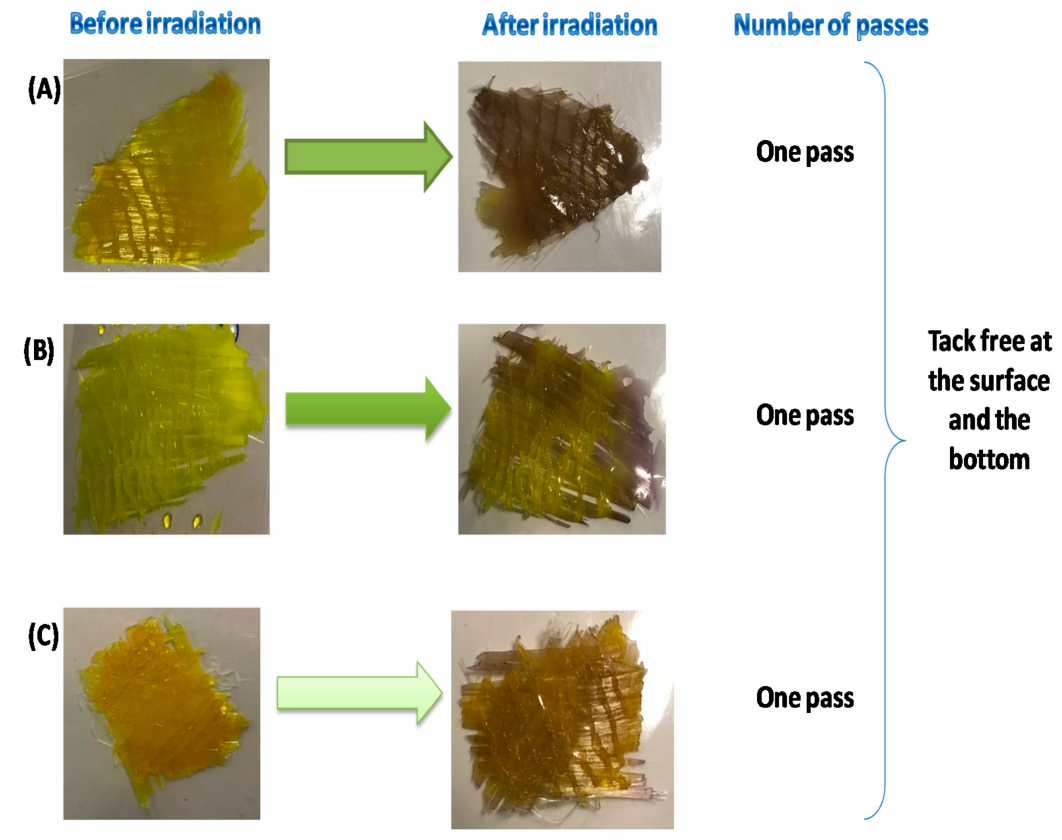
Figure 3. Photocomposite synthesis, Belt Speed = 2 m / min, using LED @ 385 nm: ( A ) Coum1 / Iod / NPG (0.1% / 1% / 1% w / w / w ) in TA, ( B ) Coum2 / Iod / NPG (0.1% / 1% / 1% w / w / w ) in TMPTA and ( C ) Coum1 / Iod / NPG (0.1% / 1% / 1% w / w / w ) in